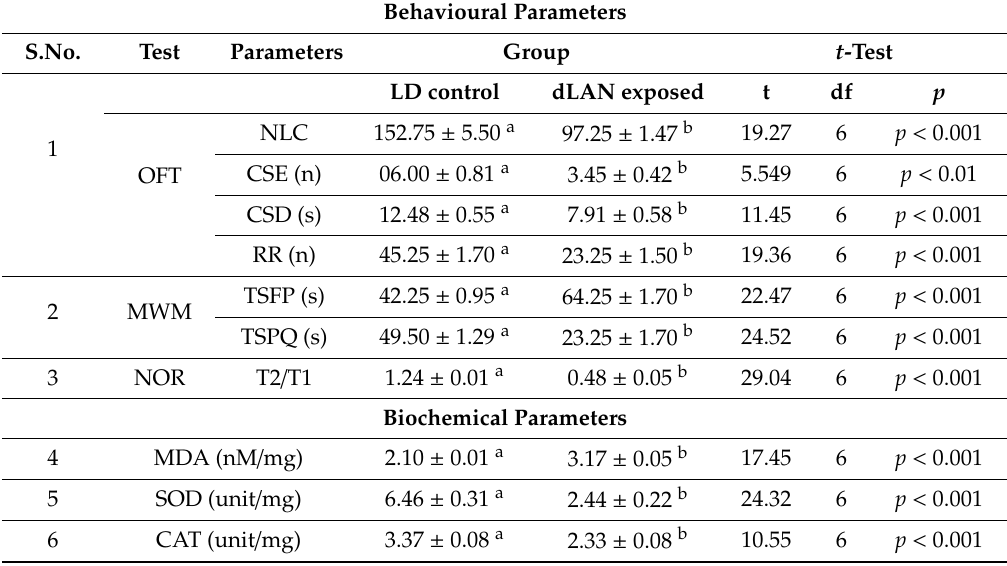
Table 1. Alterations in the behavioural and biochemical parameters in control light–dark cycle (LD) and light / dim light (dLAN) cycle exposed